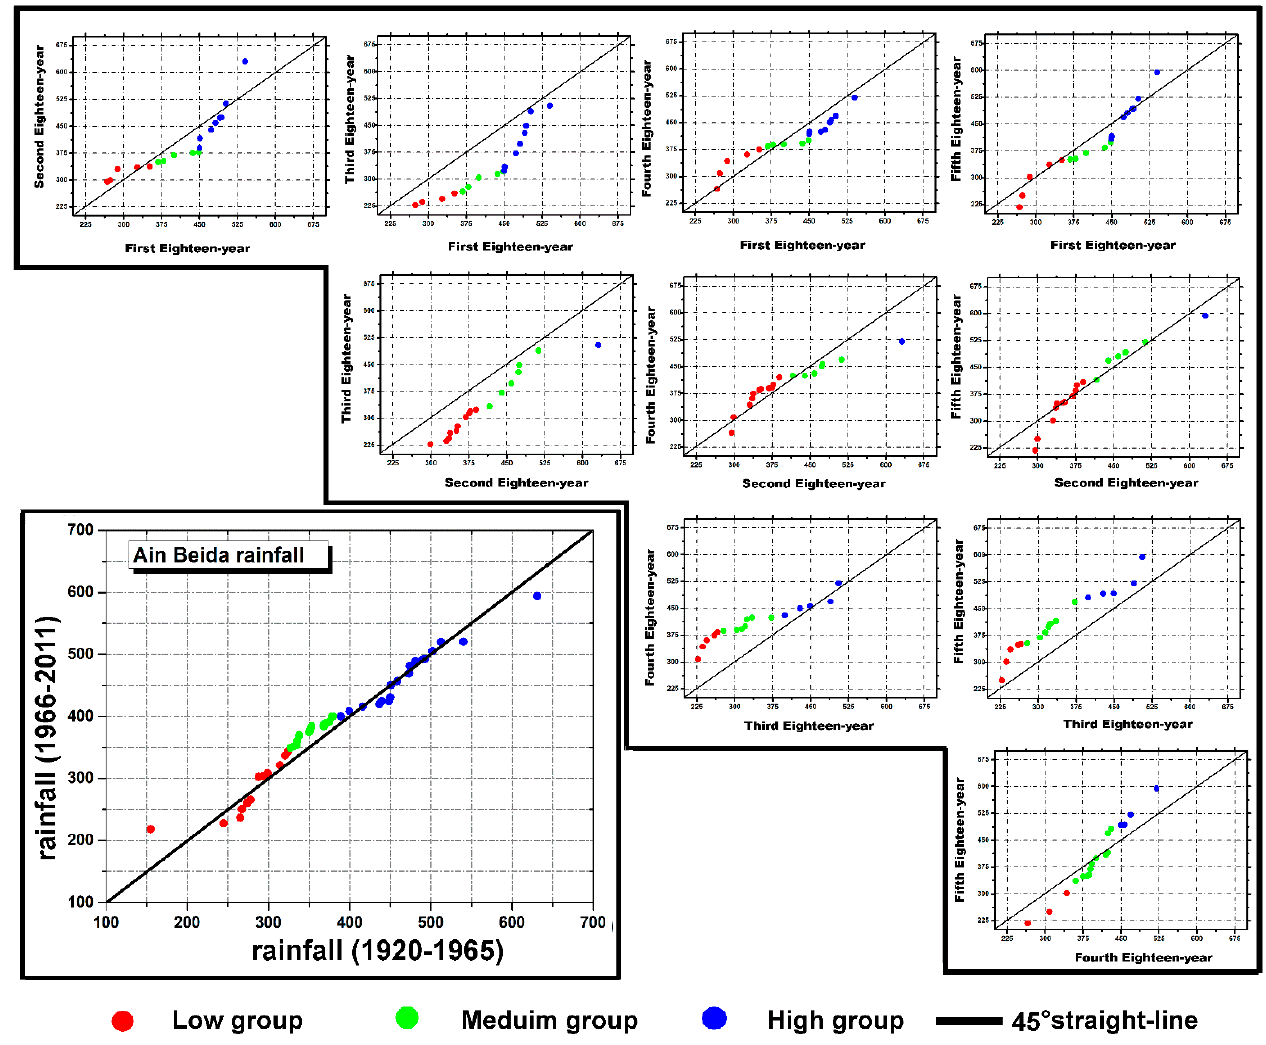
Figure 6. Triangular trend analysis methodology applied on rainfall series of Ain Beida.